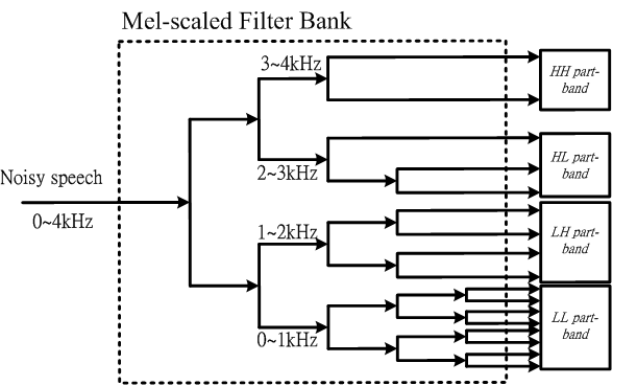
Figure 2. The structure of a four part-band partition.